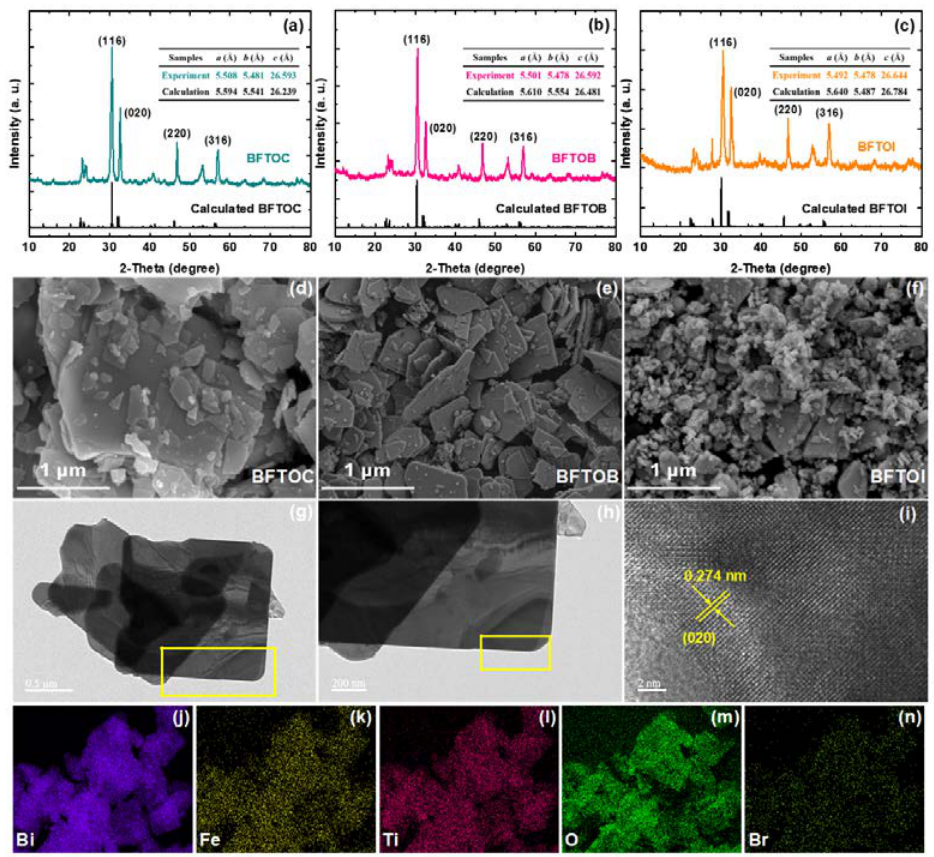
Figure 2. XRD patterns and their corresponding calculated cards of ( a ) BFTOC, ( b ) BFTOB, and ( c ) BFTOI. SEM images of ( d ) BFTOC, ( e ) BFTOB, and ( f ) BFTO-I. ( g ) TEM and the corresponding HRTEM of ( h , i ) BFTOC nanoplates in yellow squares. The corresponding SEM-EDS elemental mappings of ( j ) Bi, ( k ) Fe, ( l ) Ti, ( m ) O, and ( n ) Br for BFTOB sample.